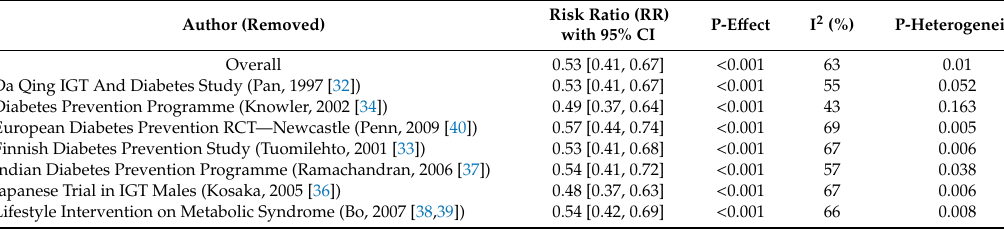
Table 2. Influence analysis assessment for the e ff ect of lifestyle changes on T2D risk.